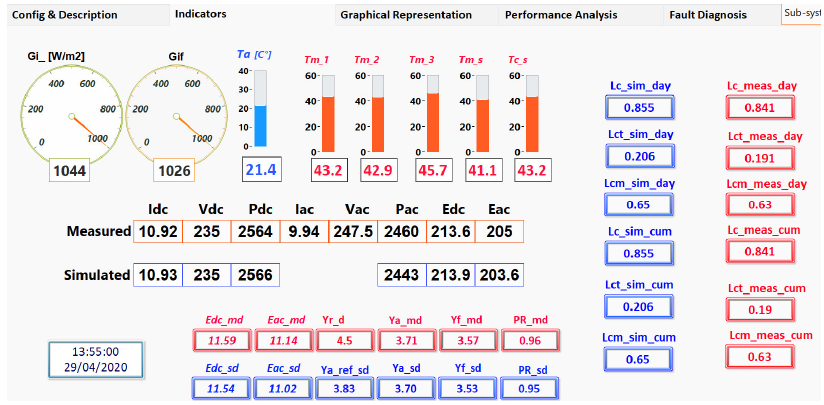
Figure 15. Modeling interface -tab for instantaneous indicators.